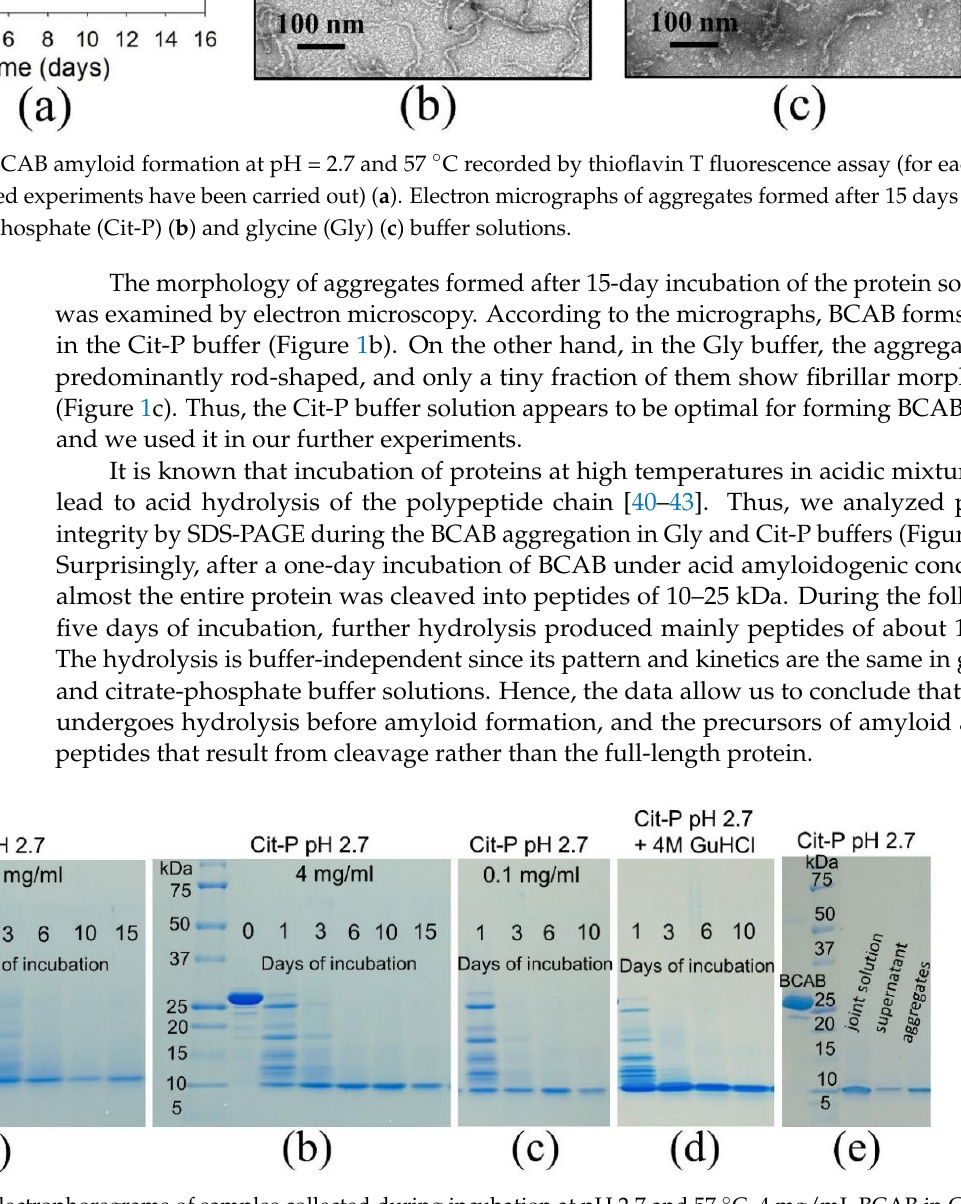
Figure 2. SDS-PAGE electrophoregrams of samples collected during incubation at pH 2.7 and 57 ◦ C. 4 mg/mL BCAB in Gly buffer ( a ); 4 mg/mL BCAB in Cit-P buffer ( b ); 0.1 mg/mL BCAB in Cit-P buffer ( c ); 4 mg/mL BCAB in Cit-P supplemented with 4M GuHCl ( d ). Samples obtained after 15 days of incubation in Cit-P at 4 mg/mL BCAB ( e ). The amount of protein applied was 10 µg per lane.